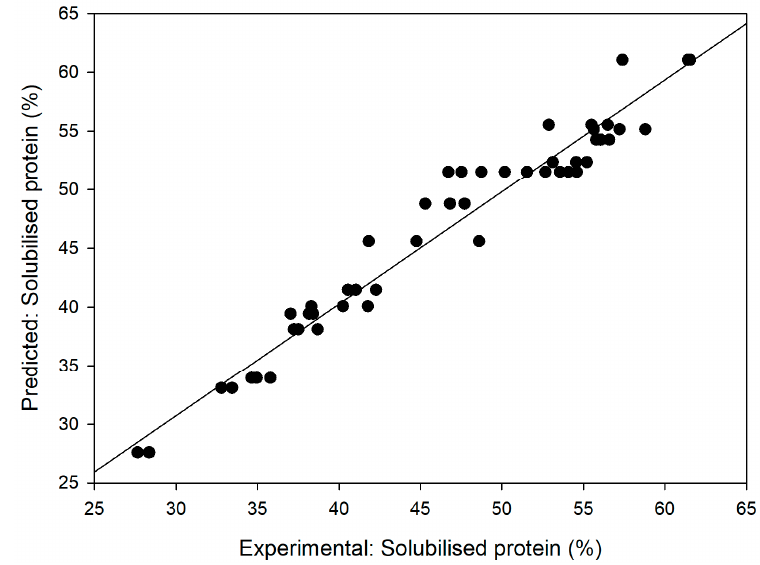
Figure 1. 3D contour plots of percentage protein solubilised from A. platensis , ( A ) extraction time and pH; ( B ) concentration and pH; ( C ) extraction time and concentration. ( D ) Perturbation plot of percentage protein solubilisation—M1. The missing variable is fixed to coded zero level. Actual